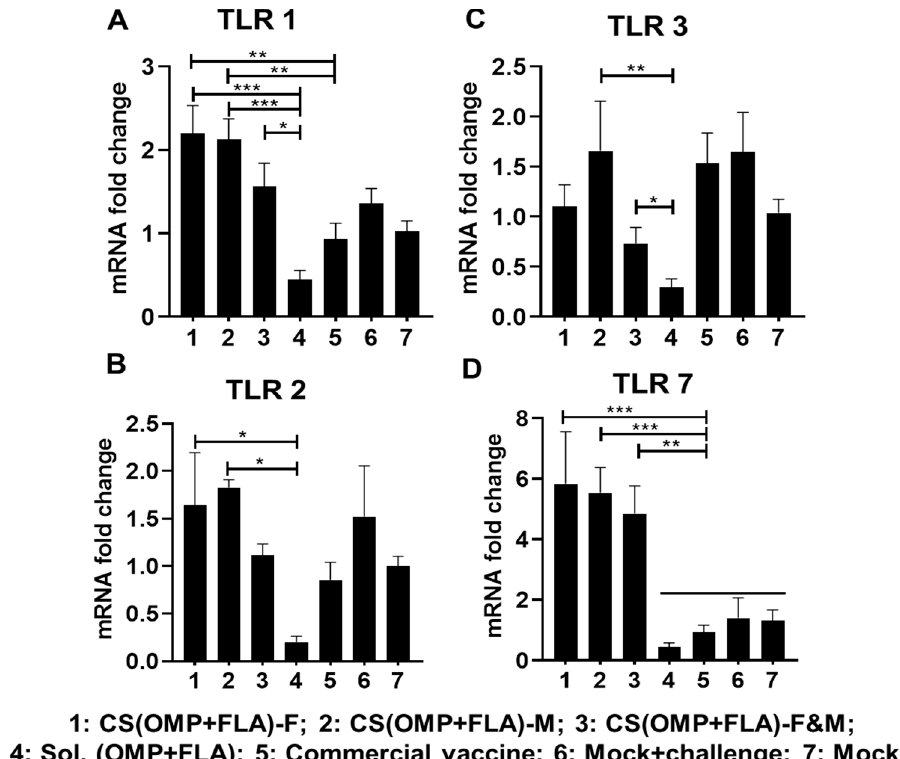
Figure 5. Toll-like receptors (TLRs) gene expression in vaccinated and challenged birds. Cecal tonsils collected on the day of necropsy were analyzed for the expression of TLR mRNA by qRT-PCR. The fold changes of ( A ) TLR 1, ( B ) TLR 2, ( C ) TLR 3, and ( D ) TLR 7. Fold change in gene expression was calculated after correcting for β -actin mRNA value and normalizing to mRNA content of mock group as 1. Data are presented as the mean ± SEM of 6 to 13 birds per group. Significant di ff erences were determined by one-way ANOVA followed by Tukey post-hoc test between each of the groups. Only significant di ff erences are labelled in the figures (* p < 0.05, ** p < 0.01, and *** p < 0.001).